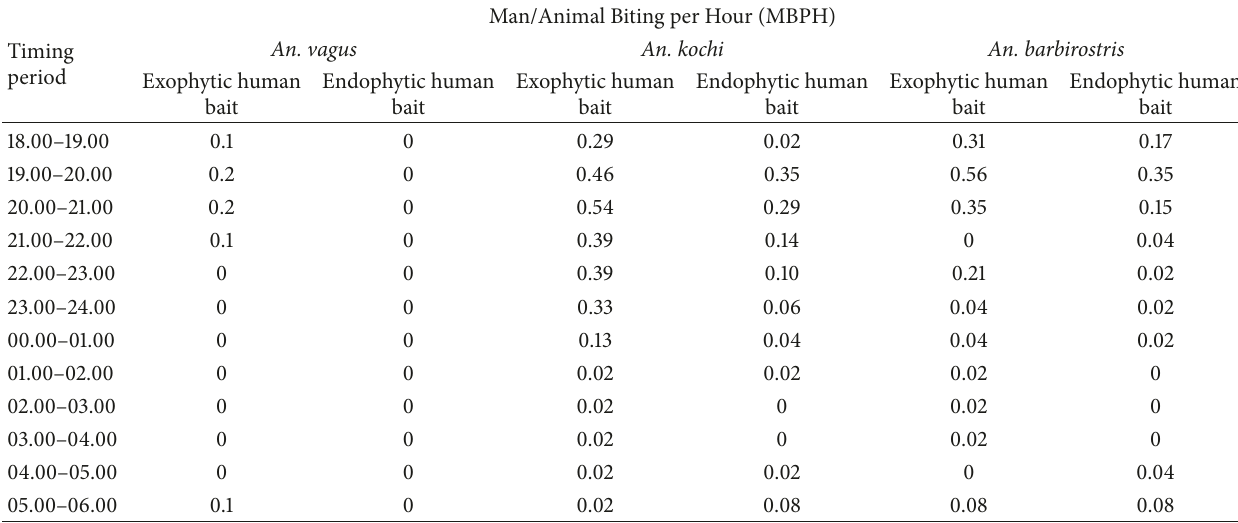
Table 3: Man/Animal Biting per Hour of An. vagus , An. kochi , and An. barbirostris .